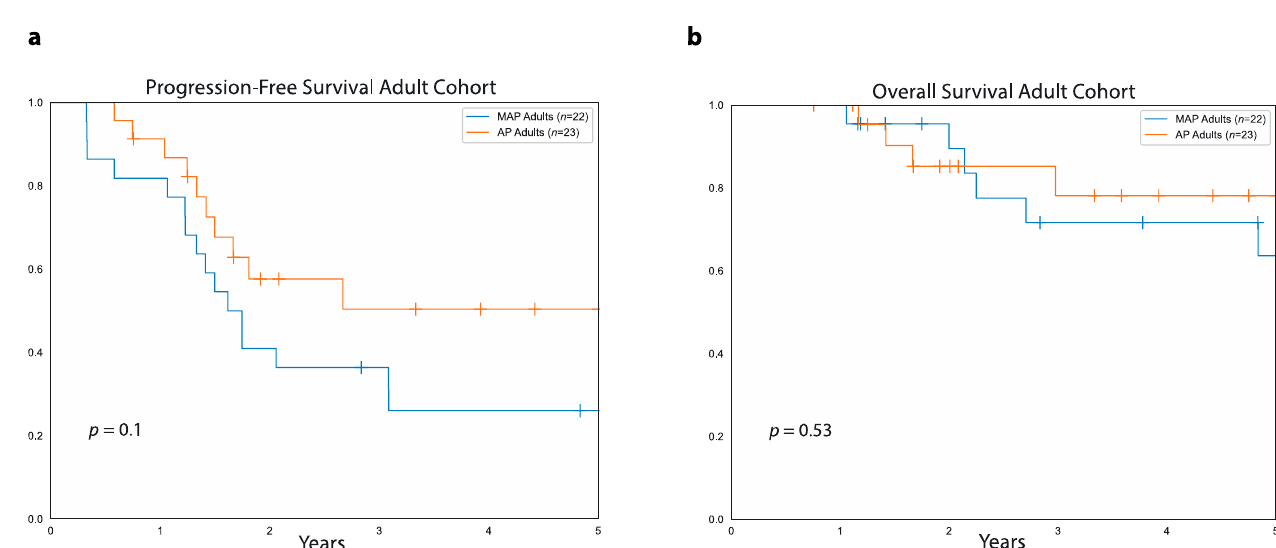
Figure 4. MAP vs. AP in adult patients with osteosarcoma. ( a ) Progression-free survival in the adult cohort for patients treated with MAP (blue curve) versus patients treated with AP (orange curve). ( b ) Overall survival for patients treated with MAP (blue curve) and patients treated with AP (orange curve) in the adult cohort. Table 2. MAP vs. AP chemotherapy in the adult